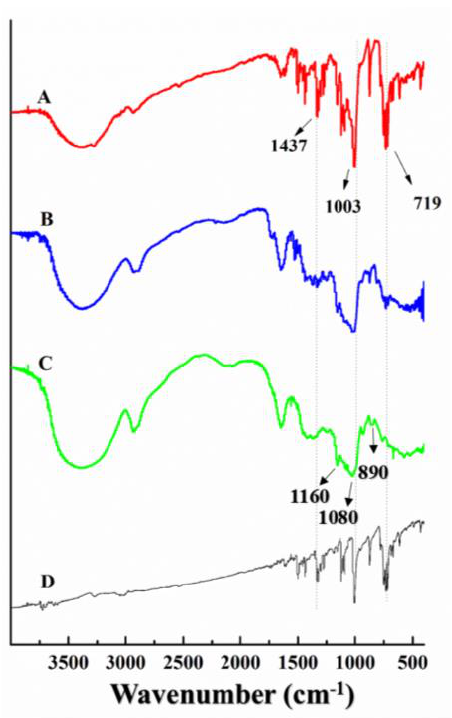
Figure 6. FTIR spectra of CUR mixed with PC (physical mixture) ( A ), CUR-PC ( B ), CUR ( C ), and PC ( D ).